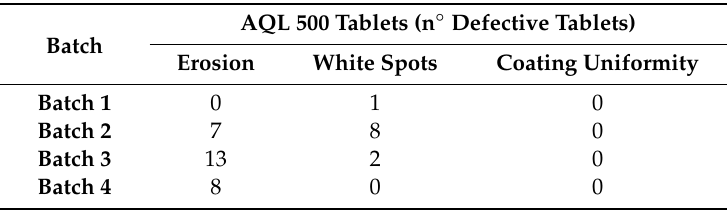
Table 6. Visual inspection results (AQL) for each validation